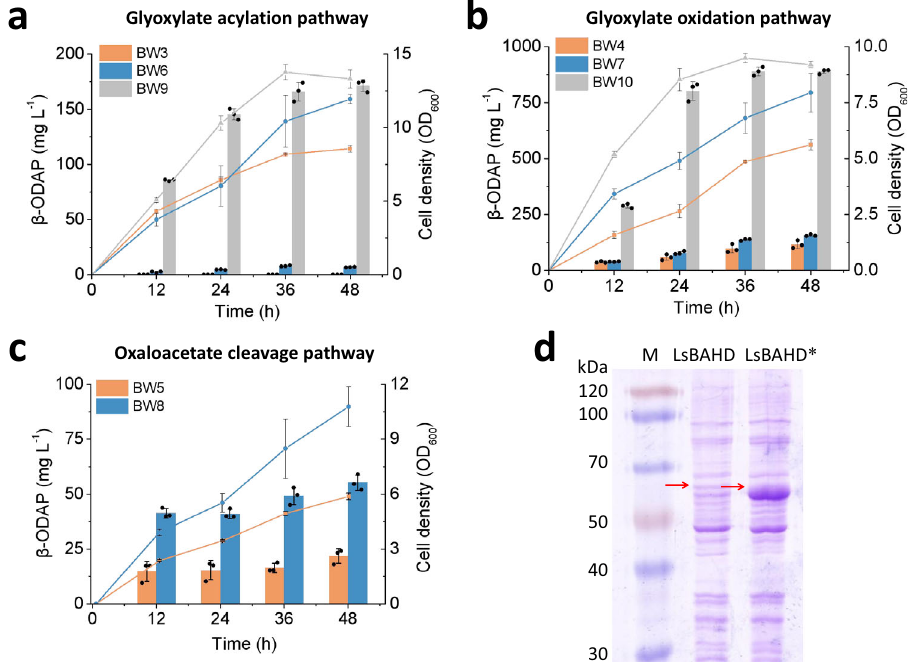
d The solubility levels of LsBAHD and LsBAHD* were identi fi ed through SDS-PAGE analysis. Red arrows indicate the bands of LsBAHD and LsBAHD*. This experiment wasrepeated independentlytwicewithsimilarresults.Sourcedataare provided as a Source Data fi le.